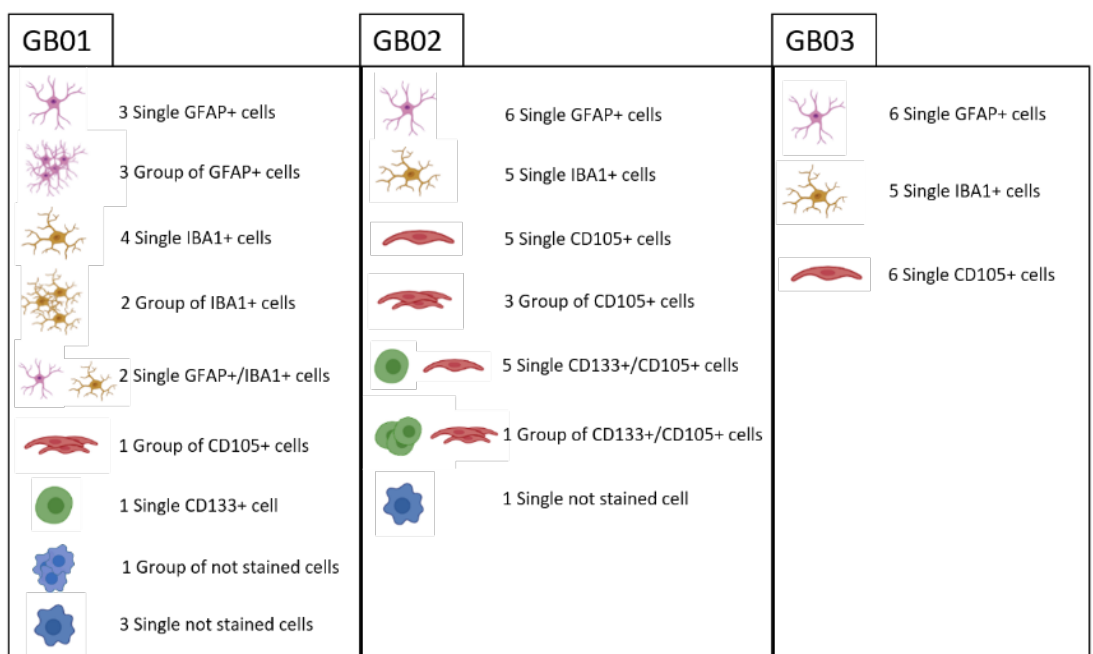
Figure 4. Summary of all the recovered cells after DEPArray analysis from GB01, GB02, and GB03. Astrocytes-like, microglia-like, endothelial-like, and stem-like cells were collected. Double staining cells and only Hoechst positive cells are shown.